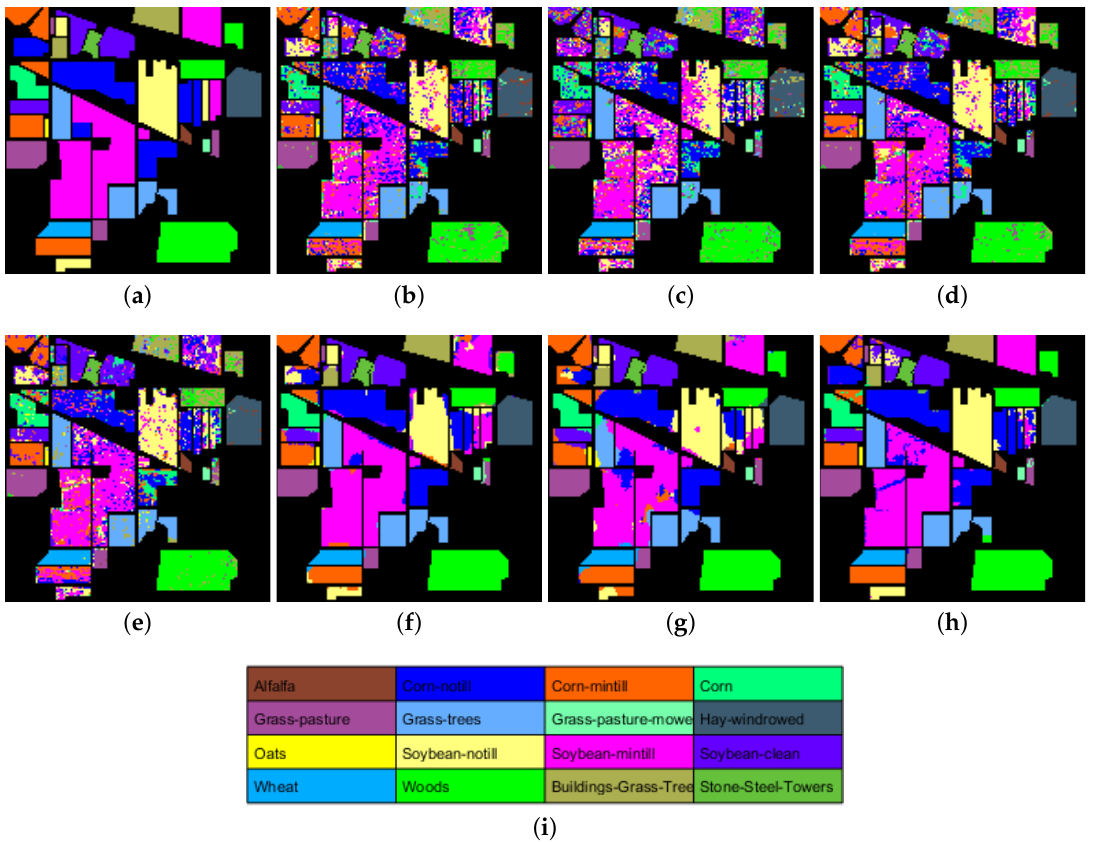
Figure 4. Classification maps of different models on the Indian Pines dataset: ( a ) ground truth; ( b ) SVM: OA = 68.43%; ( c ) ELM: OA = 61.12%; ( d ) KELM: OA = 70.15%; ( e ) PCA-KELM: OA = 70.25%; ( f ) CK-KELM: OA = 91.87%; ( g ) LBP-KELM: OA = 90.14%; ( h ) SP-KELM: OA = 94.50%; and ( i ) color bars for land